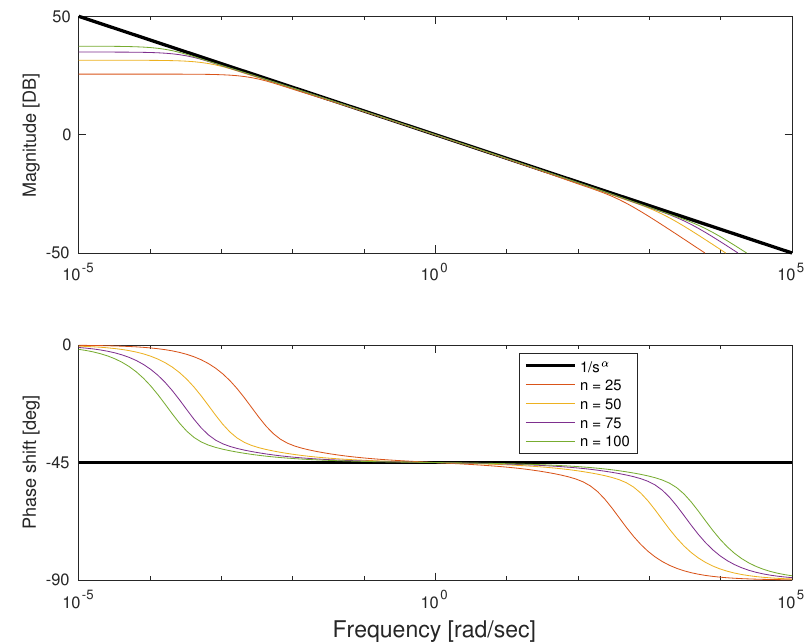
Figure 4. Bode plot for approximation order 25 to 100 for Fourier–Chebyshev quadrature.